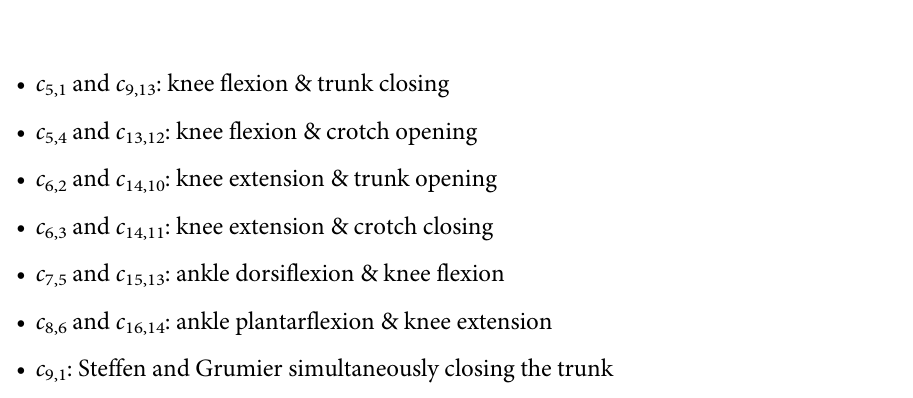
Fig 15. Knee and ankle angles. Light rectangles: ActiveROM , active range of motion from Faisal et al. [14]. Dark rectangles: WalkingROM , walking range of motion from Mentiplay et al. [15]. Red lines: average values of the angles. (A,B) The knee angles of Steffen and Grumier vary around the lower limit of WalkingROM , fencers bend their knees. (C,D) The ankle angles of Steffen and Grumier are mainly within WalkingROM .